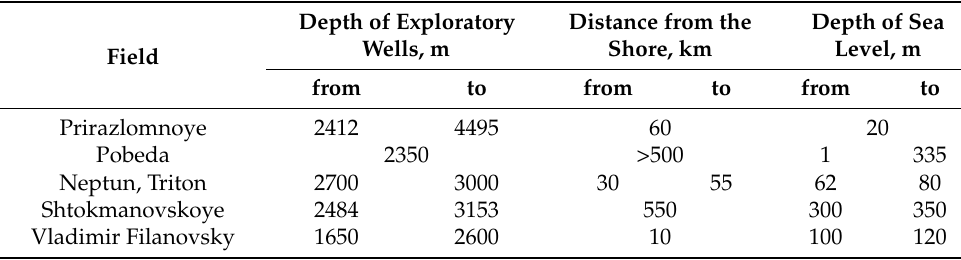
Table 2. Data on Russian offshore projects.